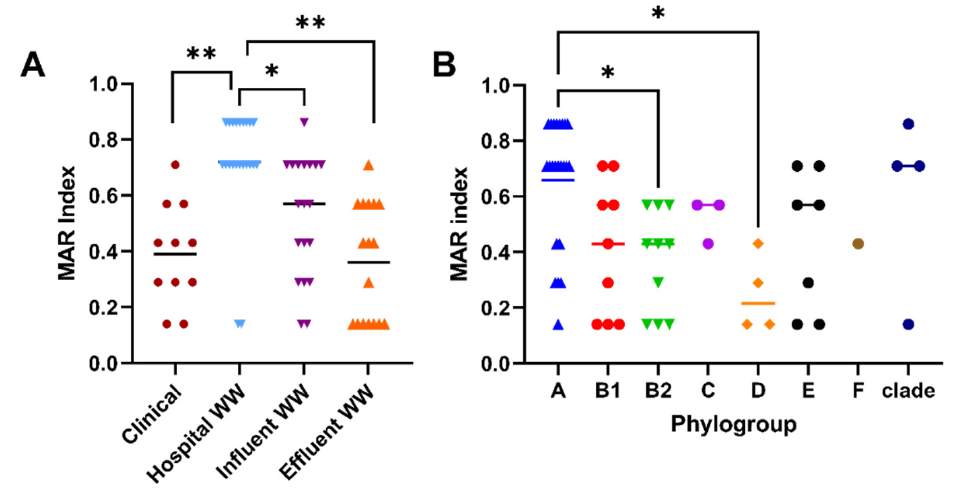
Figure 2. Antibiotic resistance among sample sources and phylogroups. ( A ) Multiple antibiotic resistance (MAR) index was determined by dividing the number of resistant antibiotic categories by the total number of antibiotic categories ( n = 7) per isolate. ( B ) Phylogroup of total isolates was determined using the revised Clermont method. Each mark represents one isolate. The mean of each group is represented by a bar. Statistical differences between sources or phylogroups was determined using Tukey’s multiple comparison test. * p < 0.05; ** p < 0.001.